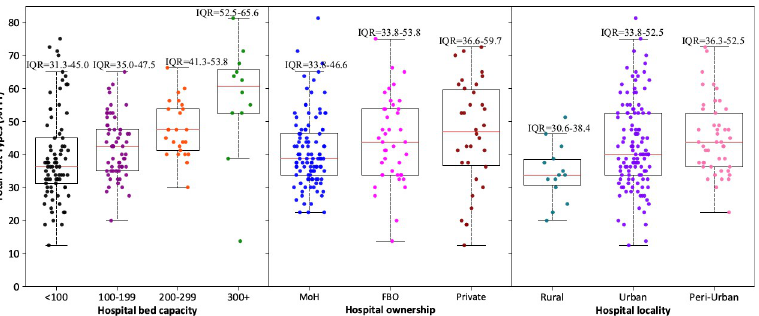
Fig 5. Testing scope in relation to the hospital bed capacity, hospital ownership and locality among general hospitals in Kenya based on DHIS2 laboratory data of the years 2018 and